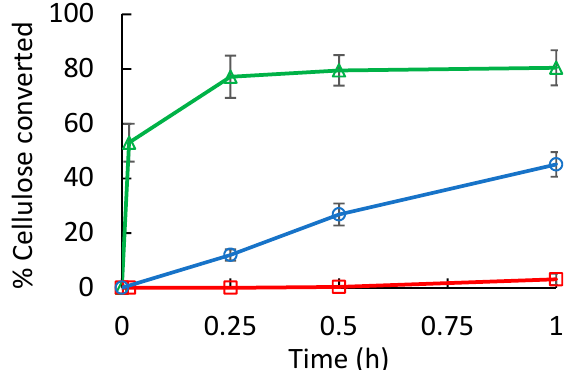
Figure 7. Hydrolysis of WSCA ( ∆ ) compared with that of microcrystalline cellulose ( □ ) and cellulose hydrogel ( ○ ).